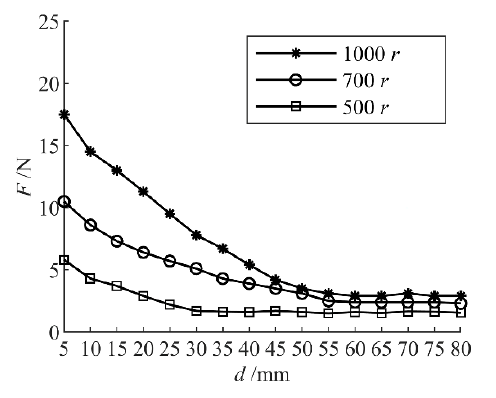
Figure 11. F- d diagram ( δ = 0.2).